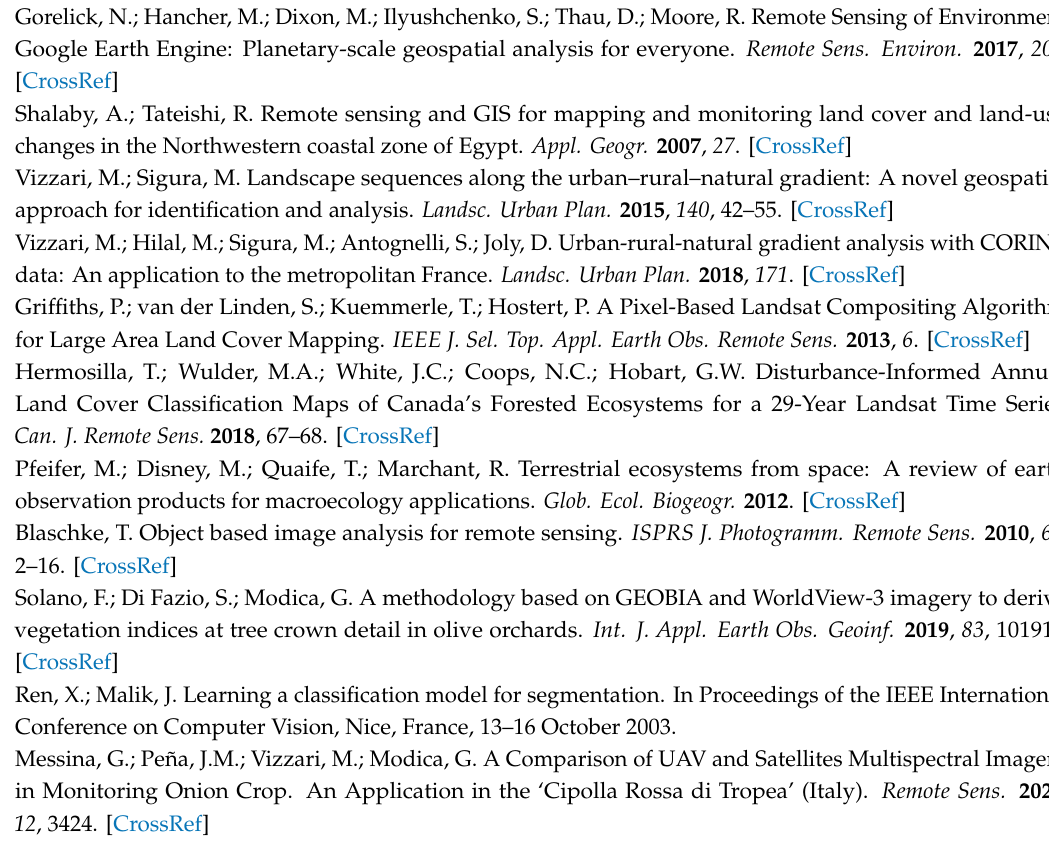
Table S1: PB and OO confusion matrices for L8, Table S2: PB and OO confusion matrices for S2, Table S3: PB and OO confusion matrices for PS. The GEE codes processing S2 data, developed in this research, are freely available on line at https: // code.earthengine.google.com / ?accept_repo = users / mvizzari / Tassi_Vizzari_RS2020. Author Contributions: Conceptualization, M.V. and A.T.; methodology, M.V. and A.T.; software, A.T.; original draft preparation, A.T.; writing—review and editing, M.V. All authors have read and agreed to the published version of the